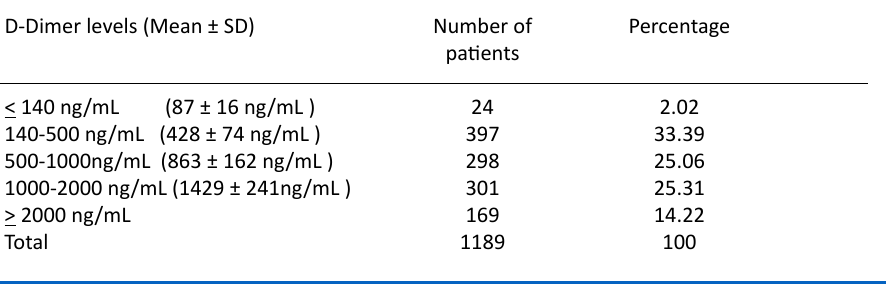
Table 2. D-dimer levels in the patients D-Dimer levels (Mean ±